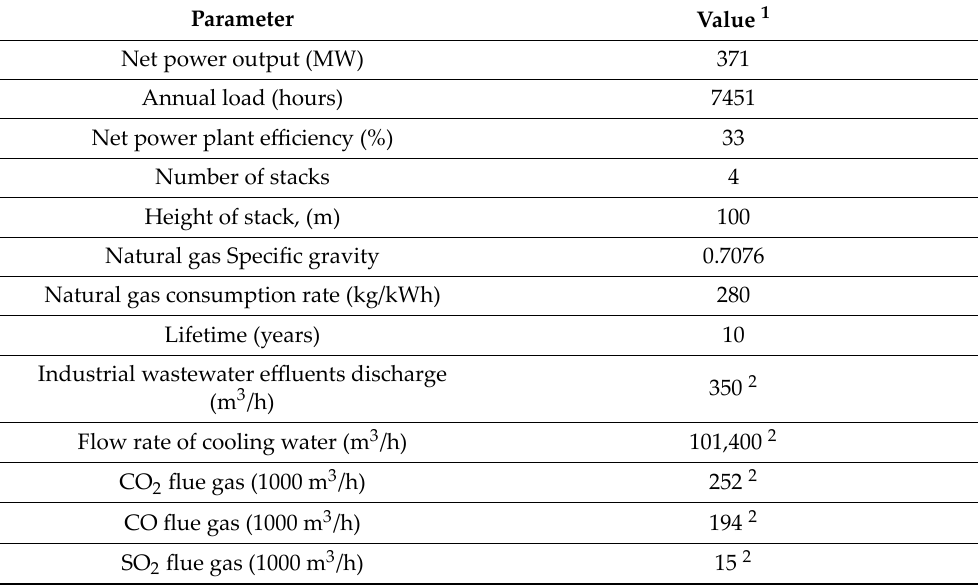
Table 2. Key parameters of the Hartha power plant.